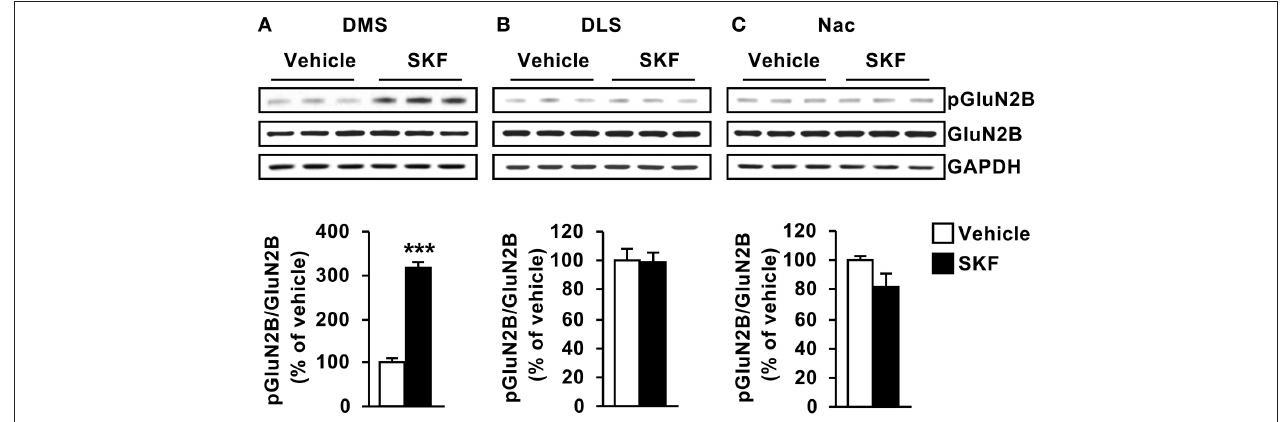
FIGURE 2 | D1R-dependent GluN2B phosphorylation is detected in the DMS but not in the DLS or NAC. SKF81297 (SKF, 5 mg/kg) or vehicle (2% DMSO) was systemically administered (i.p.). The DMS (A) , DLS (B) , and NAc (C) were collected 15 min after drug administration. The level of Tyr1472[GluN2B] phosphorylation (pGluN2B, top panels), GluN2B (middle panels), and GAPDH (lower panels) were determined by western blot analysis. Data are presented as the mean densitometry value of the pGluN2B divided by the mean densitometry values of the total GluN2B ± SEM and expressed as % of vehicle. Two-tailed t -test. *** p < 0.001, n = 5–6 mice per treatment.